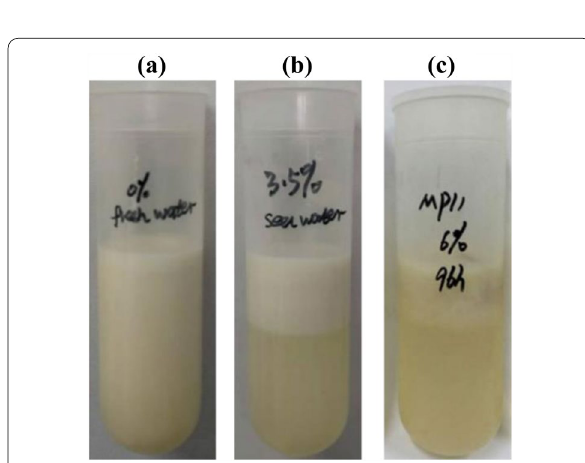
Fig. 5 Broth samples of T. cutaneum MP11 under different salinities. These samples were cultured for 96 h in a fresh water, b 3.5% salinity, and c 6.0% salinity, respectively